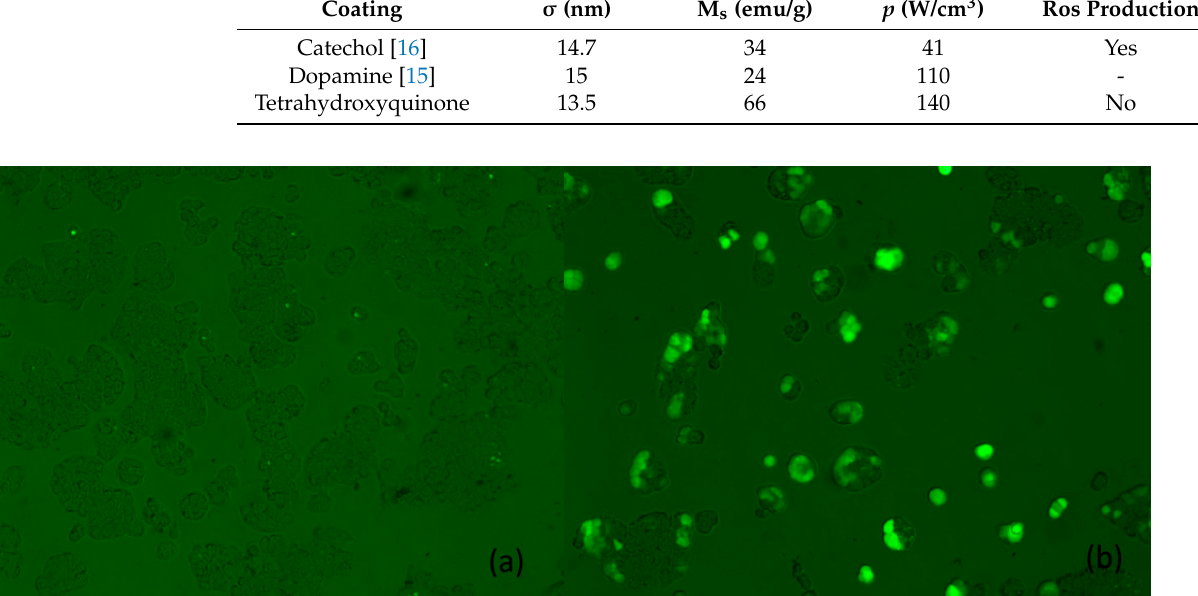
Figure 7. Relative metabolic activity of HT-29 cells ( a ) exposed to different concentrations of THQ-coated IONPs (black axis and dots) and pure THQ (red axis and open dots), respectively, ( b ) and HT-29 cells with 2 mg/mL of THQ-coated IONPs treated for 15 min with MHT and reaching different temperatures. Error bars indicate SD.